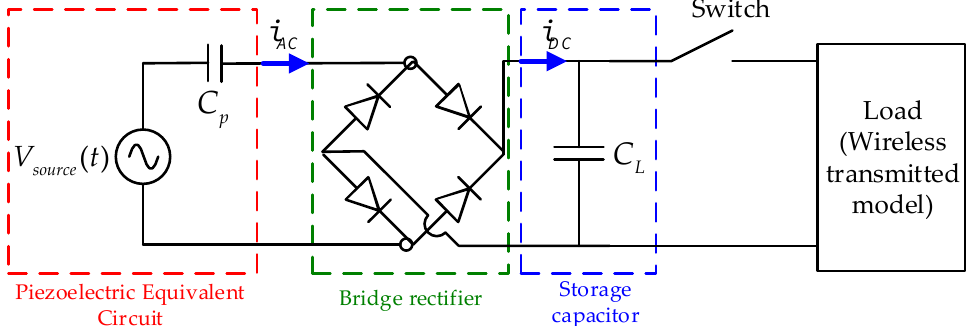
Figure 7. Theoretical electric circuit of proposed piezoelectric harvesting system.